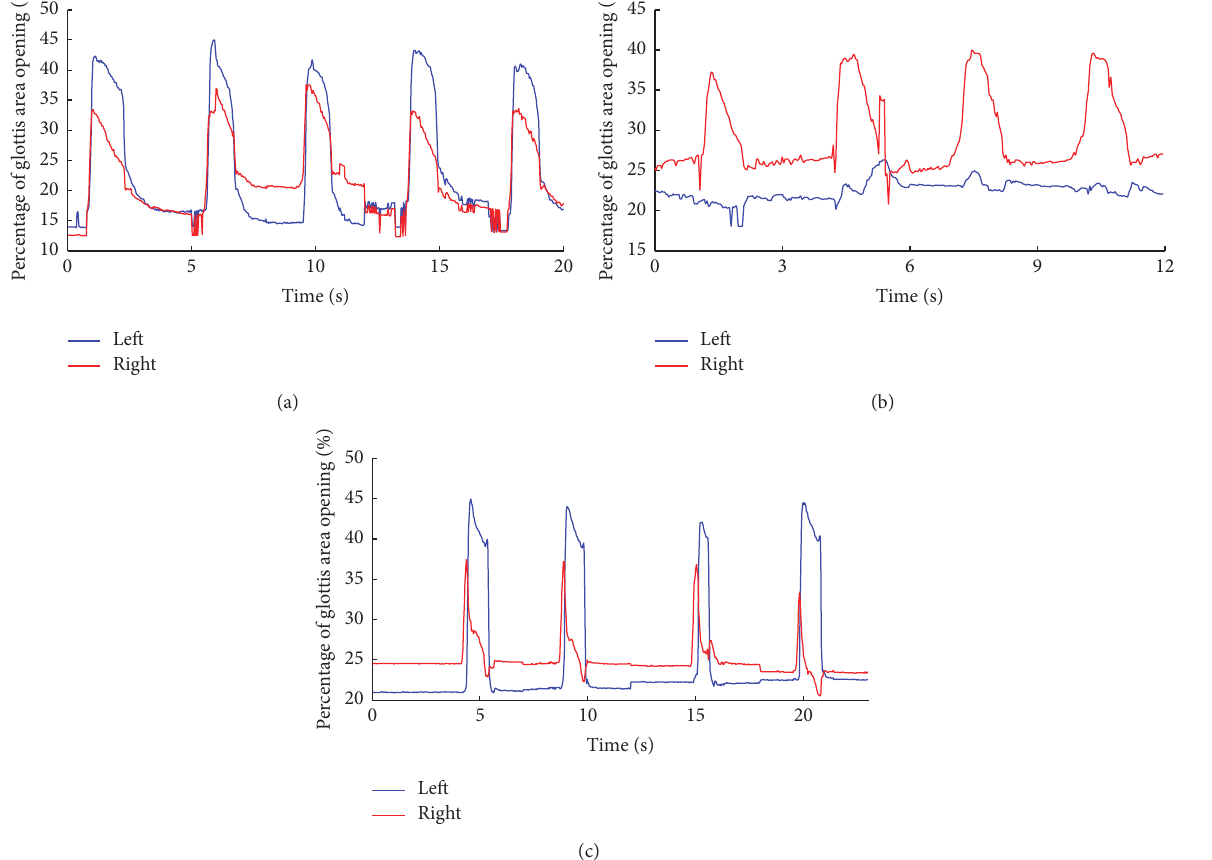
Figure 5: Displacement of vocal fold across experiment conditions. The movements of left (blue) and right (red) vocal fold were separately calculated. (a) Changes of glottis area in the intact state. (b) Changes of glottis area following left RLN destruction. (c) Changes of glottis area following pacing with feedback from CT EMG. The left (injured) and right (healthy) sides of glottis movements were plotted using blue and red solid lines,